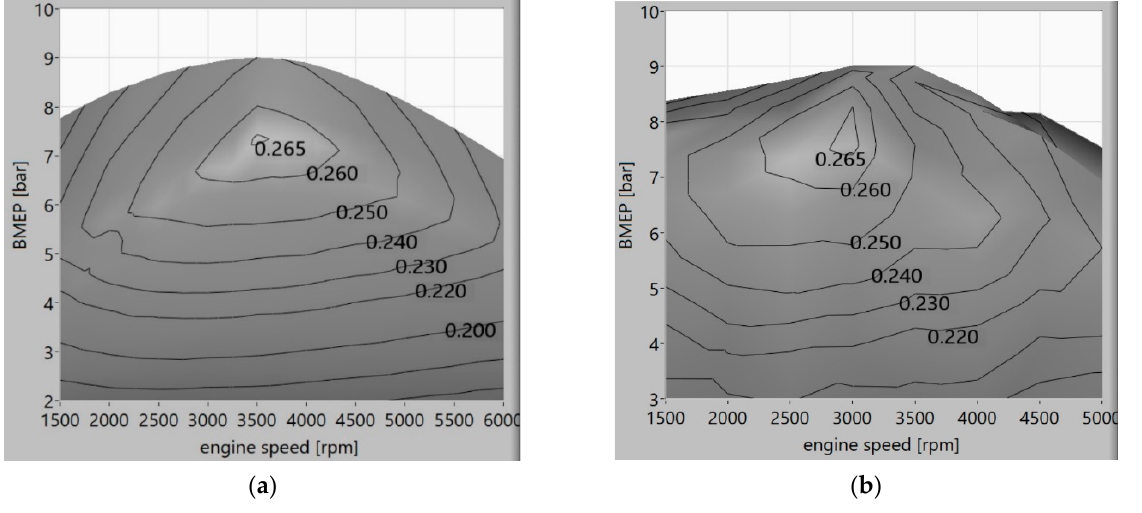
Figure 3. Simulated ( a ) and experimental ( b ) BTE maps of the gasoline ‐ fueled engine.